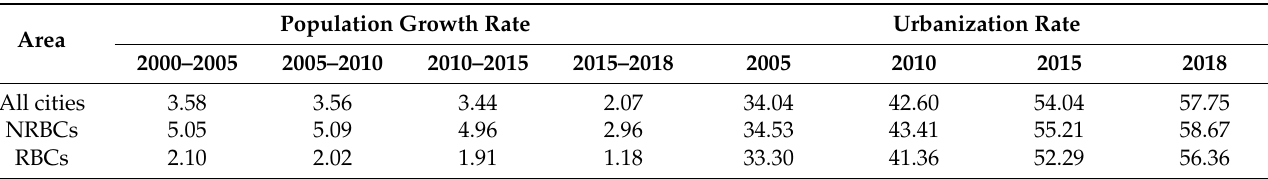
Table 5. Population growth rate and urbanization rate (%).